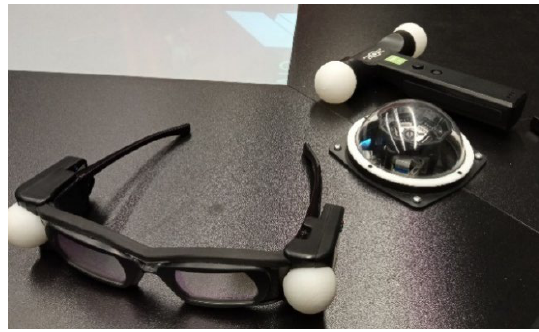
Figure 3. The wand, glasses, and infrared tracking dome.